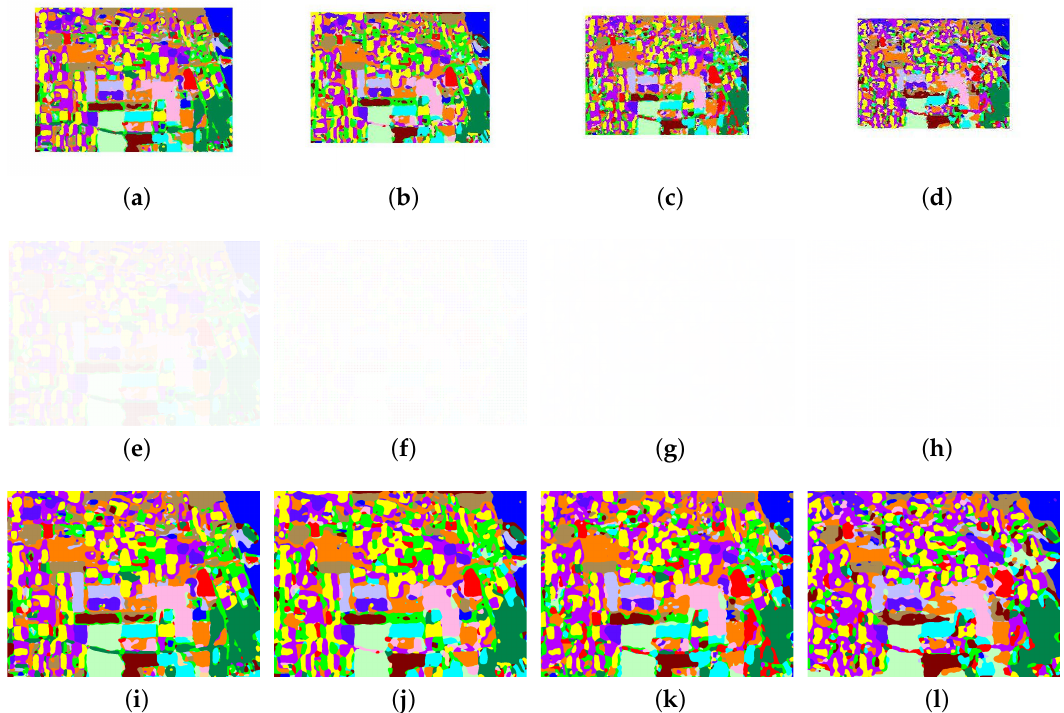
Figure 6. Pauli RGB pseudo-colored images and their terrain information from PolSAR database Flevoland from NASA/JPL AIRSAR: ( a – d ) classification results of light network for images with 1 1 , and 1 down-sampling rates, respectively; ( e – h ) completed label priors ˆ Y with corresponding 25 14 down-sampling rates; and ( i – l ) final completed label maps for the entire image with same down-sampling rates as in ( a – d